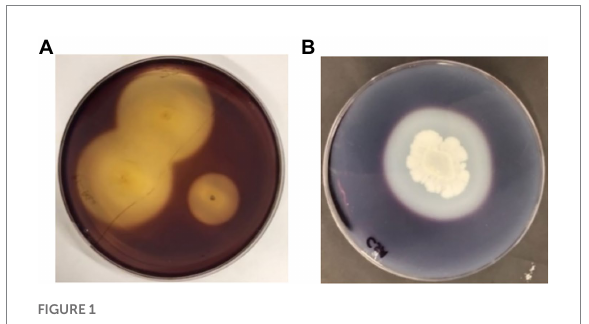
FIGURE 1 Screening test for (A) pectinase, and (B) amylase. FIGURE 2